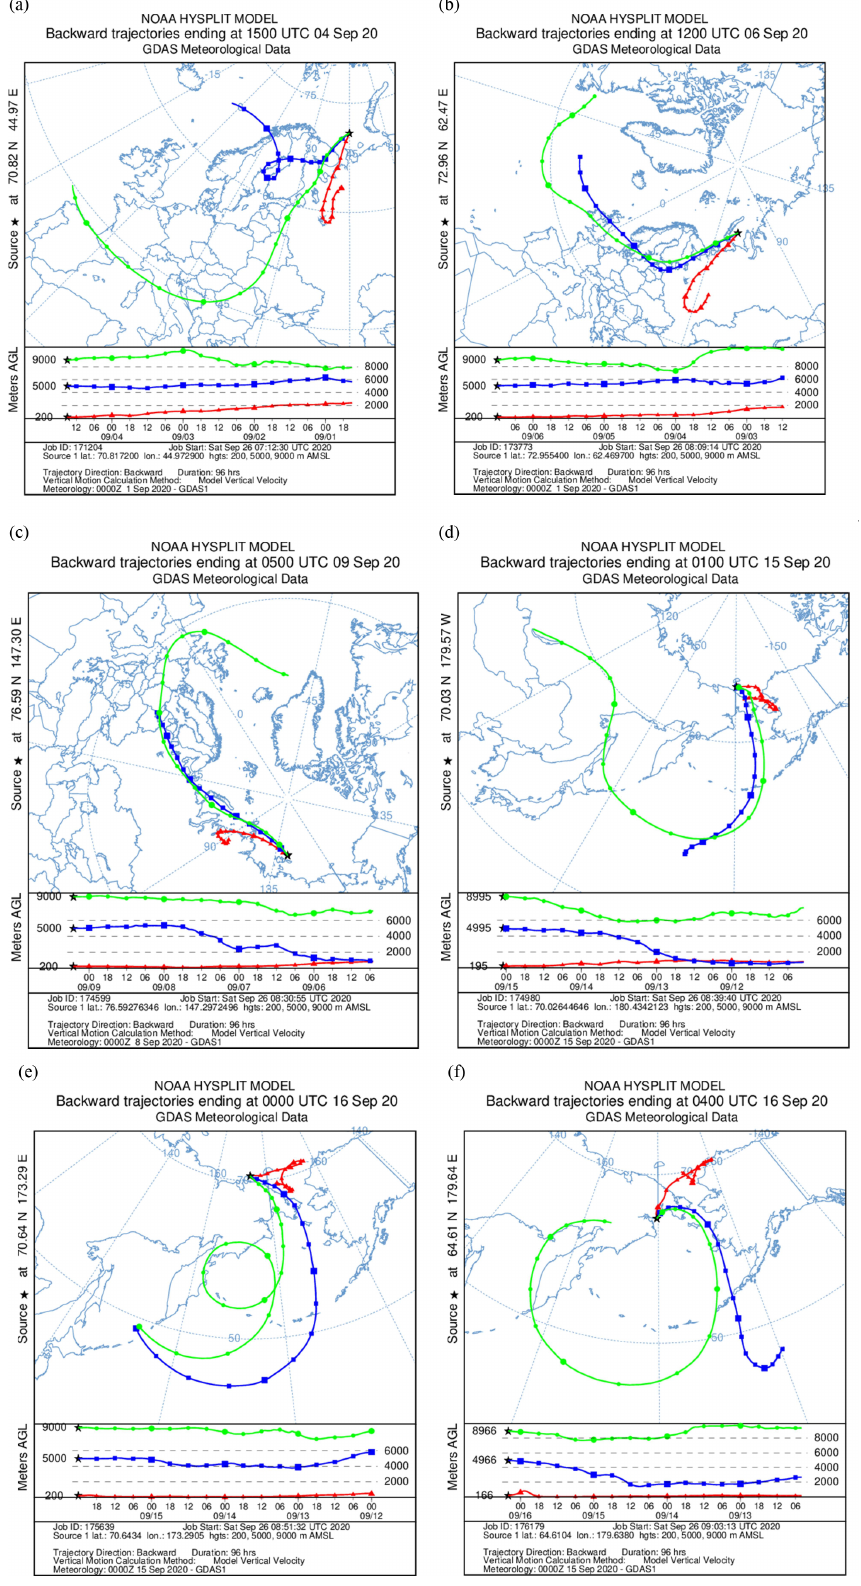
Figure 9. Back trajectories for the period of the